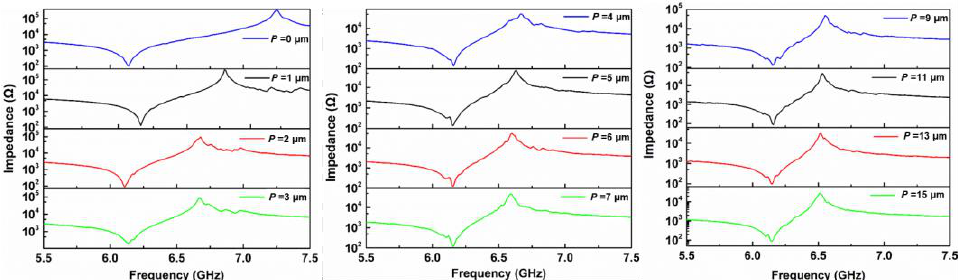
Figure 4. The impedance curves of XBARs with different widths of nonpiezoelectric materials ( P ) ranging from 0 to 15 µm.